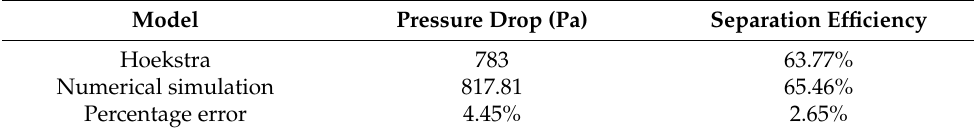
Table 8. Validation of pressure drop and separation efficiency